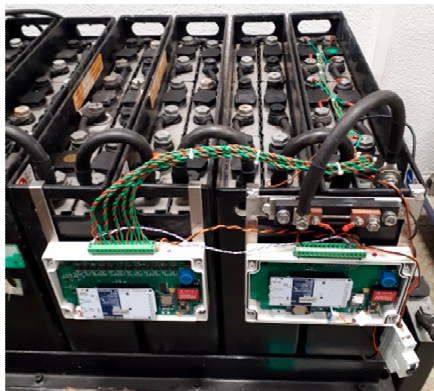
Figure 6. Implementation in a battery.